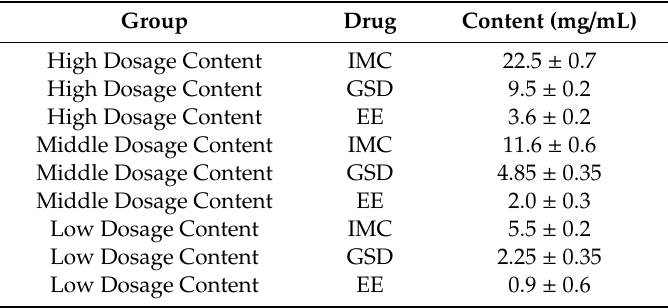
Table 1. Di ff erent groups with di ff erent drug content for investigating in vitro release profiles of indomethacin (IMC), gestodene (GSD), and ethinyl estradiol (EE). Group Drug Content (mg /